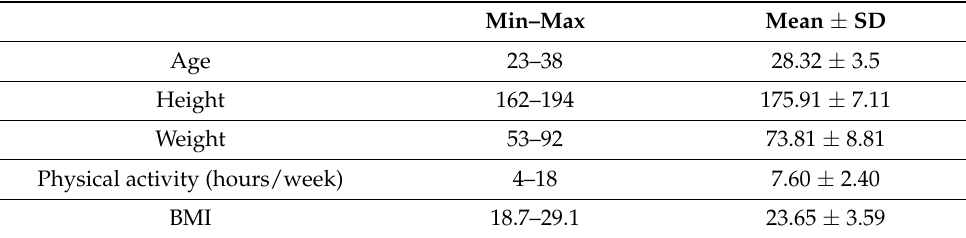
Table 1. Anthropometric variables in the